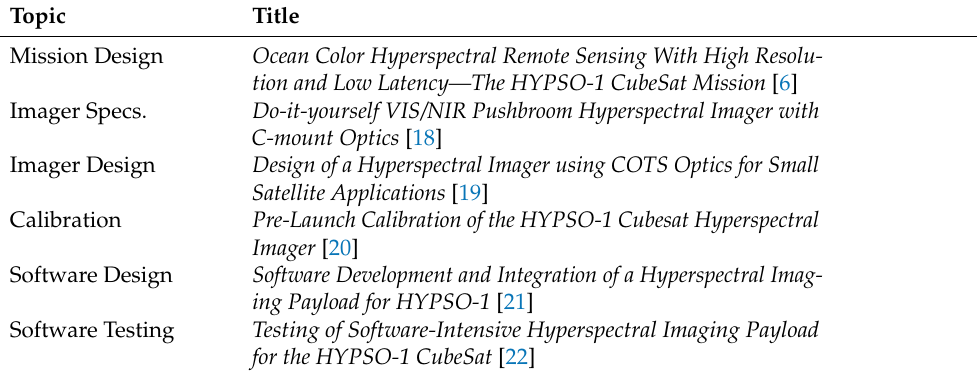
Table 1. Summary of selected supplementary works about the HYPSO-1 mission and payload, for